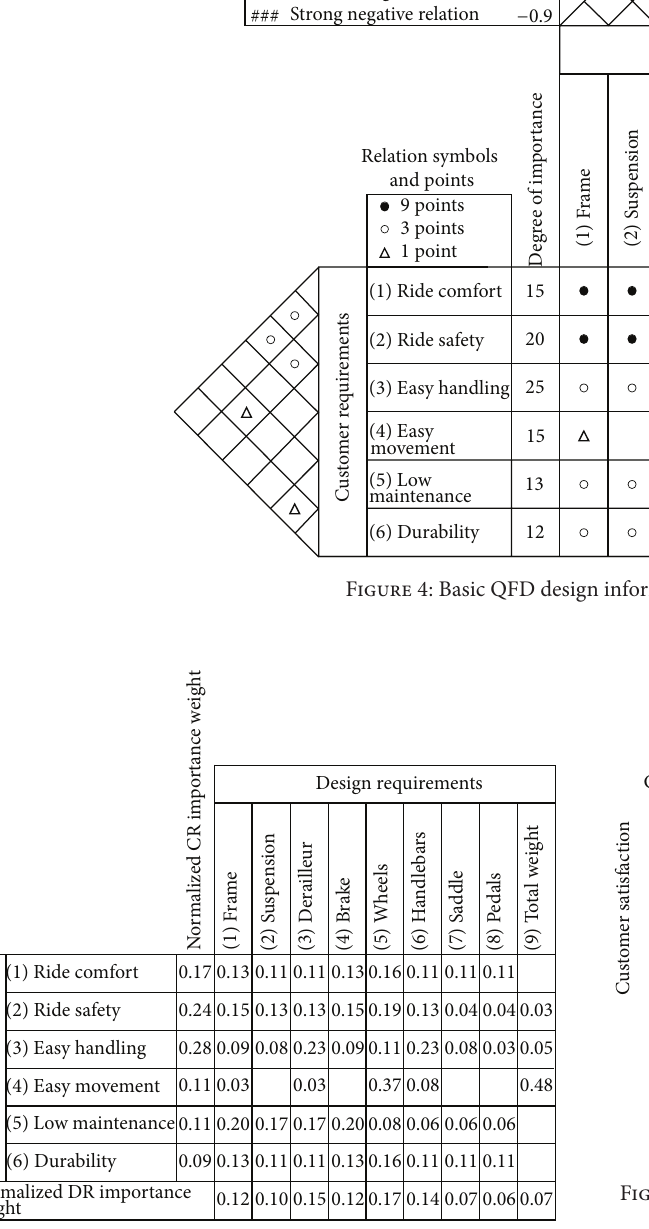
Figure 5: Normalized results for product.